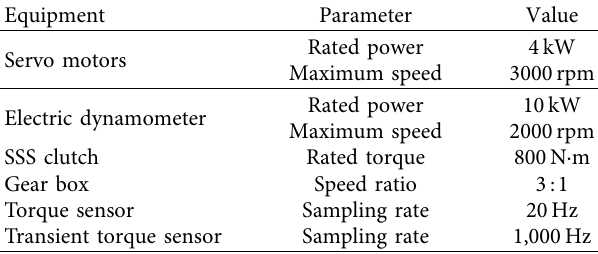
Table 1: Parameters of the experimental